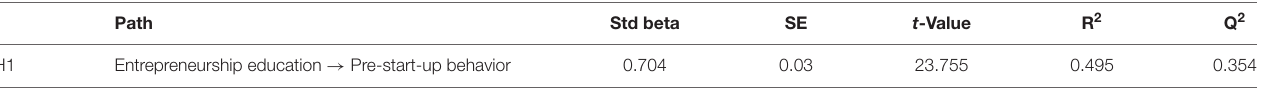
TABLE 9 | Structural model assessment (Full dataset).